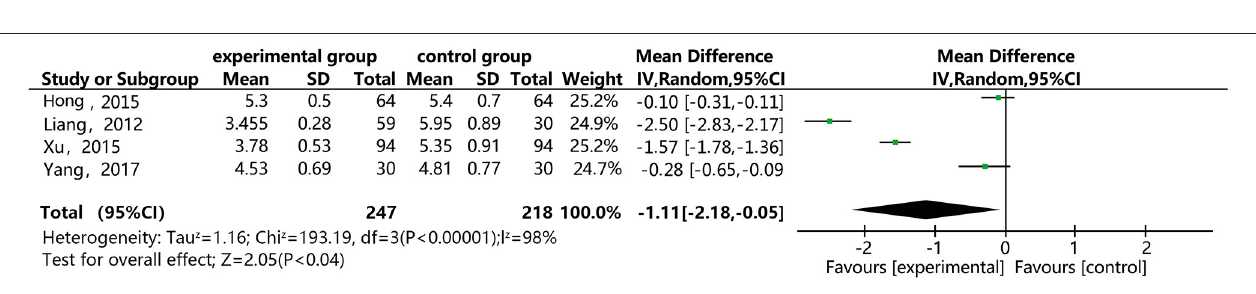
FIGURE 8 | Meta-analysis forest map for the effect of DSP combined with aspirin on hematocrit in patients with CHD.